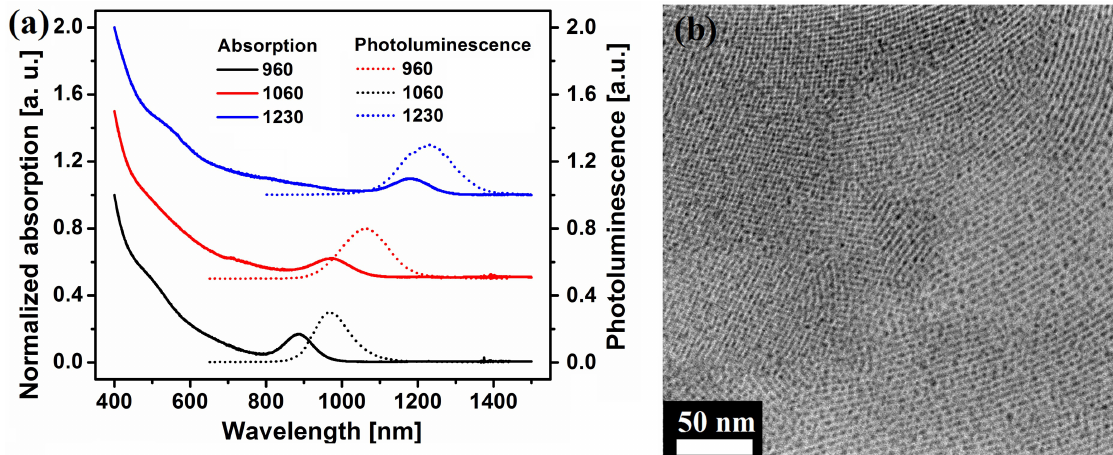
Figure 1. ( a ) Absorption (solid line) and photoluminescence (dotted line) spectrum of the as-synthesized PbS quantum dot (QD) with three different sizes; the QDs are identified using their photoluminescence peaks. “960” represents the QDs with photoluminescence peak at 960 nm; “1060” represents the QDs with photoluminescence peak at 1060 nm; “1230” represents the QDs with photoluminescence peak at 1230 nm. ( b ) TEM image of synthesized PbS QDs with an average size of ~3